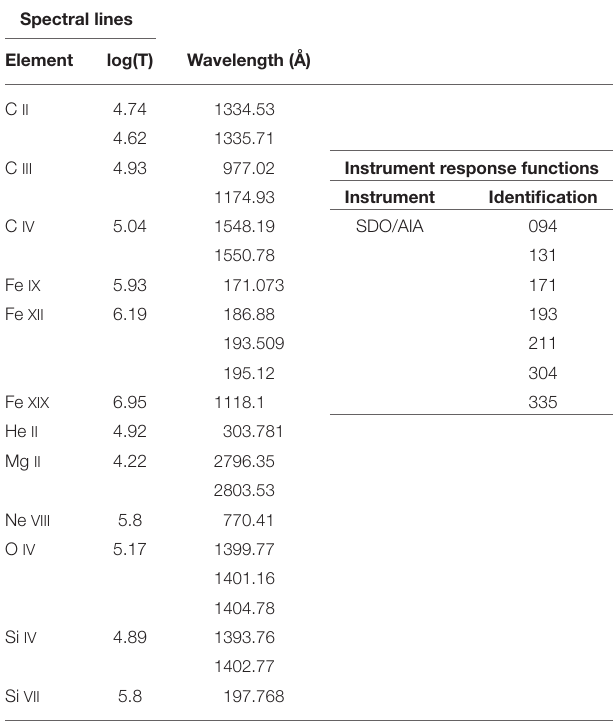
TABLE 1 | List of tabulated emission in